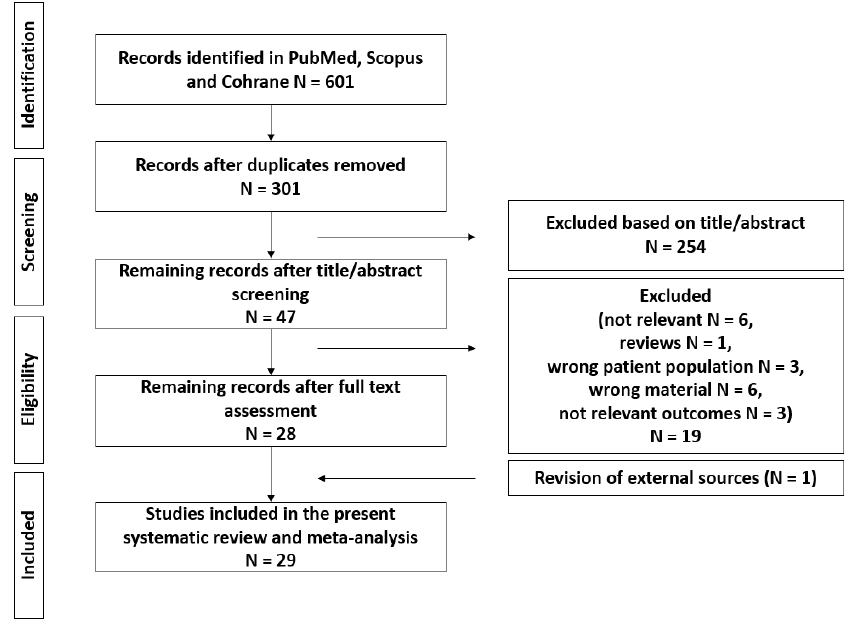
Figure 1. Flowchart for data collection according to PRISMA guidelines.